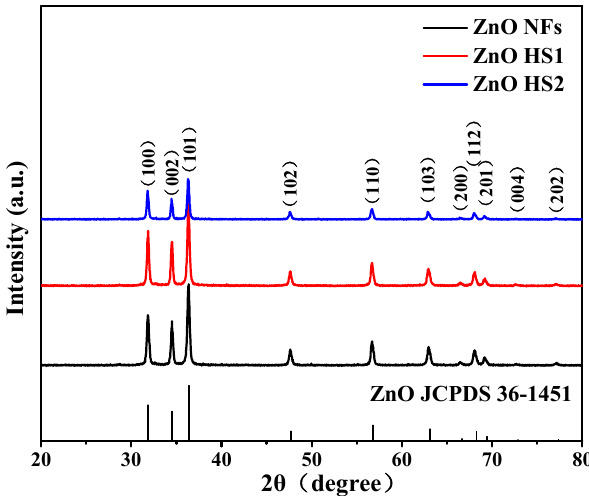
Figure 2. XRD patterns of as-prepared ZnO nanofiber (NF), firecracker-like ZnO (ZnO HS1) and flower-like ZnO (ZnO HS2)